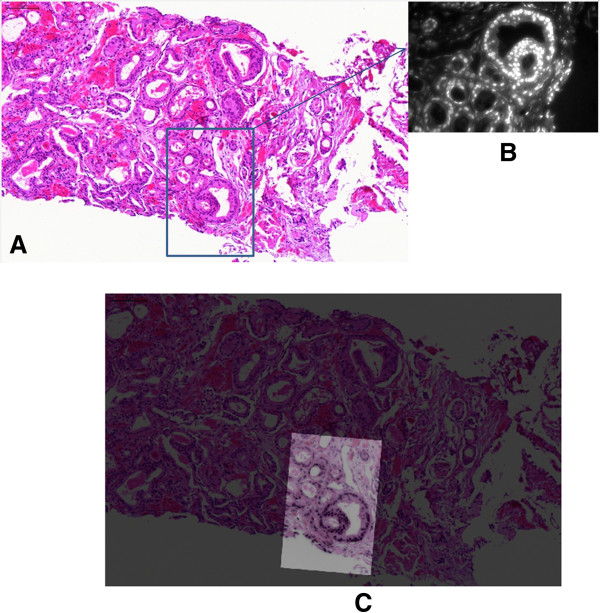
Successful alignment of H&E and AR. A, tissue section of a prostate biopsy, stained for H&E (20x magnification); B, the same tissue section stained for AR using TRF (40x). C, Successful alignment shown as an overlay of image B onto image A. The staining procedure was the following: first the tissue section was stained for AR and pictures acquired through TRF, then the AR was washed off, the section was stained for H&E and a new picture was acquired through brightfield microscopy. Considering that AR is the protein to be quantified, it is important that AR expression is preserved and therefore that the tissue is minimally stressed. Since the tissue is processed twice and this might alter its structure and protein content, we have performed AR as the first staining. H&E on the other hand did not seem to be highly influenced by intermediate steps.